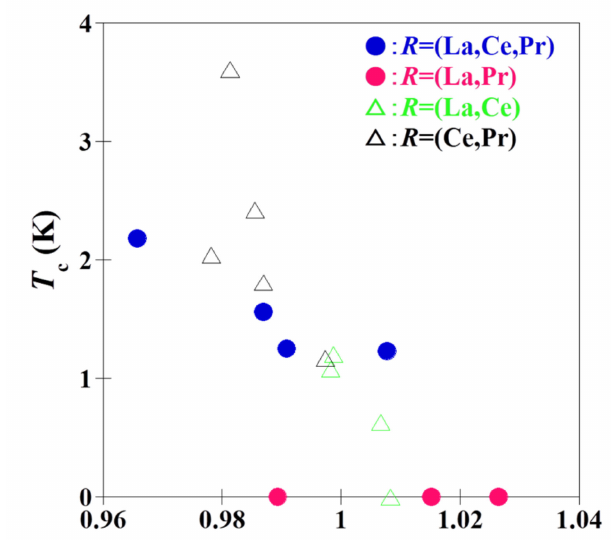
Figure 8. Relationship between the mean R -site ionic radius considering the valence state ( R 3+ and R 4+ ) and the T c for the binary and ternary R OBiS 2 single